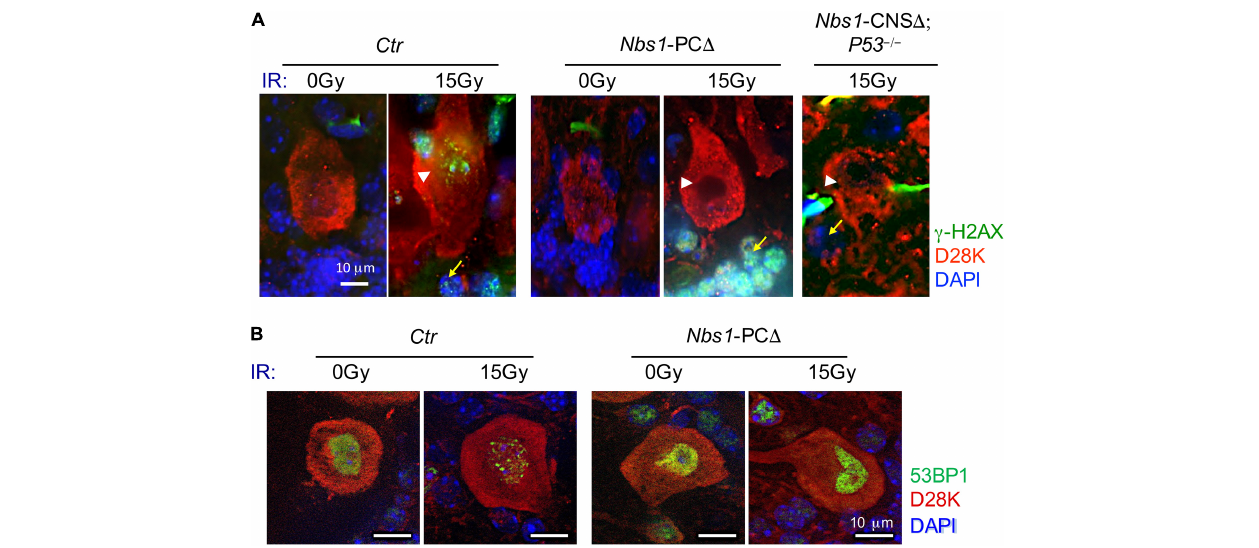
FIGURE 2 | DDR was impaired in Nbs1 -deleted Purkinje cells. (A) Analysis of DNA damage response. Immunostaining of Purkinje cells using γ -H2AX antibody on sections of 2-month-old control ( Ctr ), Nbs1 Purkinje cells -deleted (Nbs1 -PC (cid:49) ) as well as Nbs1 -CNS (cid:49) ; P53 - / - mice without (0 Gy) or with 15 Gy ionizing radiation (IR). The sagittal cryosections 30 min post-IR were stained with DAPI (blue), Calbindin-D28K (D28K, red), and γ -H2AX (green) to label DNA, Purkinje cells, and DNA damage foci, respectively. The Purkinje cell layer is shown. Arrowheads point to Purkinje cells, arrows point to granule cells. Nbs1 -CNS (cid:49) ; P53 - / - brain section is used as a negative control of DNA damage response for Nbs1 knockout granular cells. (B) Ctr or Nbs1 -PC (cid:49) brain section with (15 Gy) or without (0 Gy) IR from panel (A) were stained with DAPI (blue), Calbindin-D28K (D28K, red), and 53BP1 (green) to label DNA, Purkinje cells, and earl DNA damage foci, respectively. Scale bars: 10 µ m. Representative images of sections from two mice are